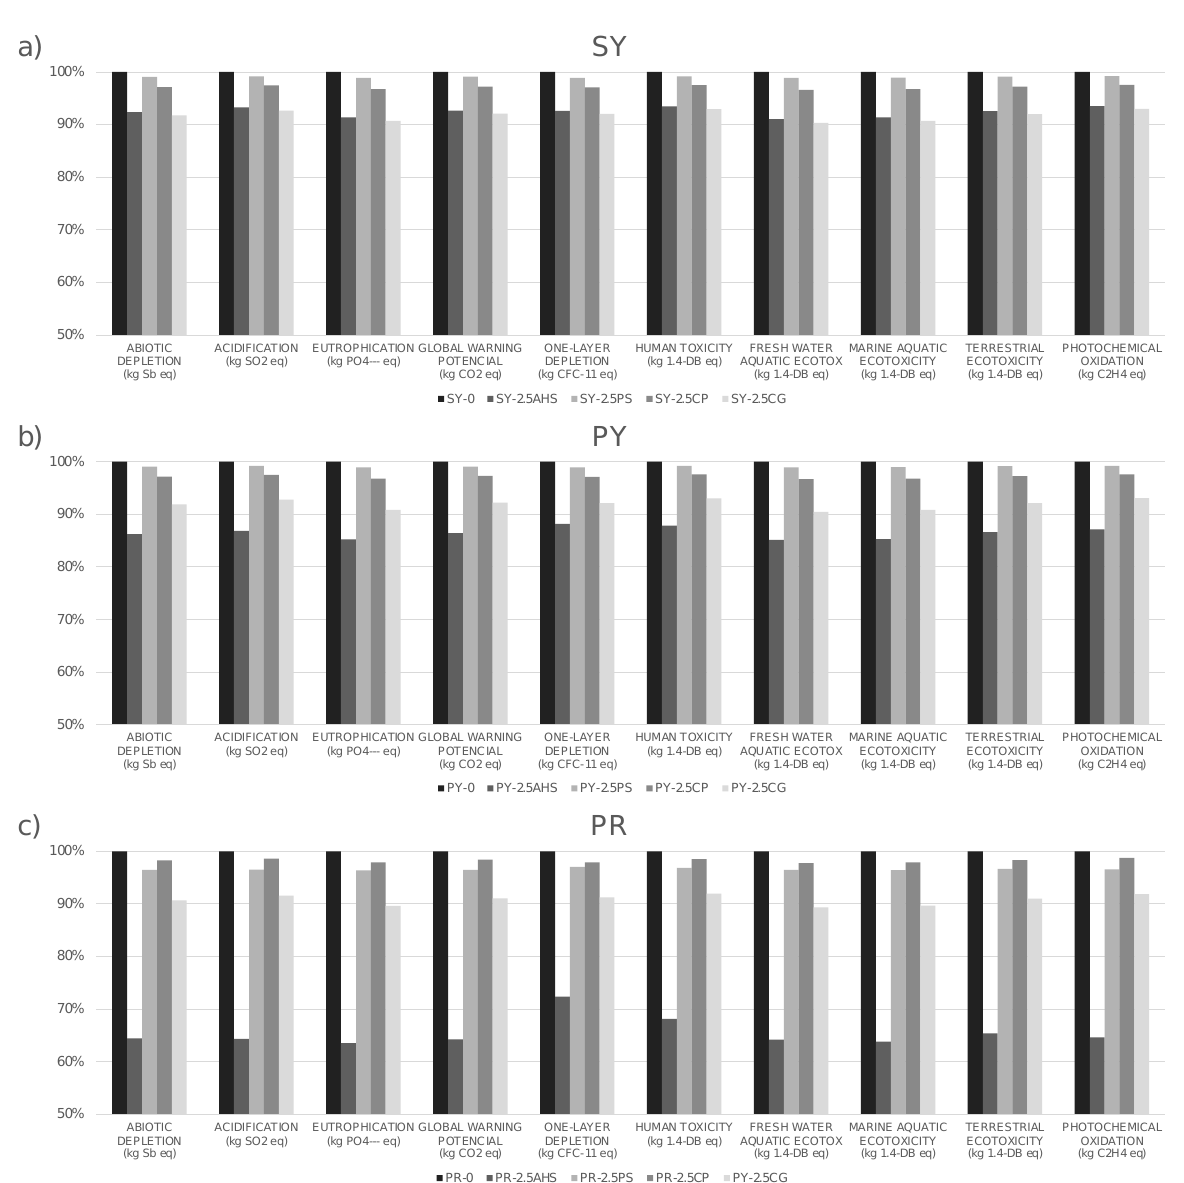
Figure 6. Characterized impact values of different impact categories of lightweight aggregates incorporating 2.5% of waste classified by clay type: SY ( a ), PY ( b ) and PR ( c ).